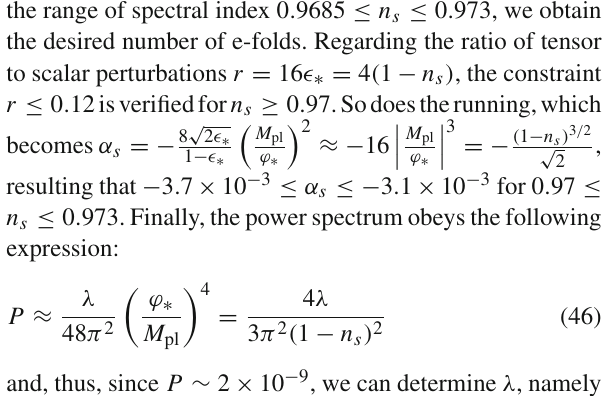
Fig. 6 Phase portrait in the plane (ϕ/ M pl , ˙ ϕ/ M 2 of the time t × M pl (right) for the same orbits represented in the phase portrait √ 2 (cid:4) α = − s